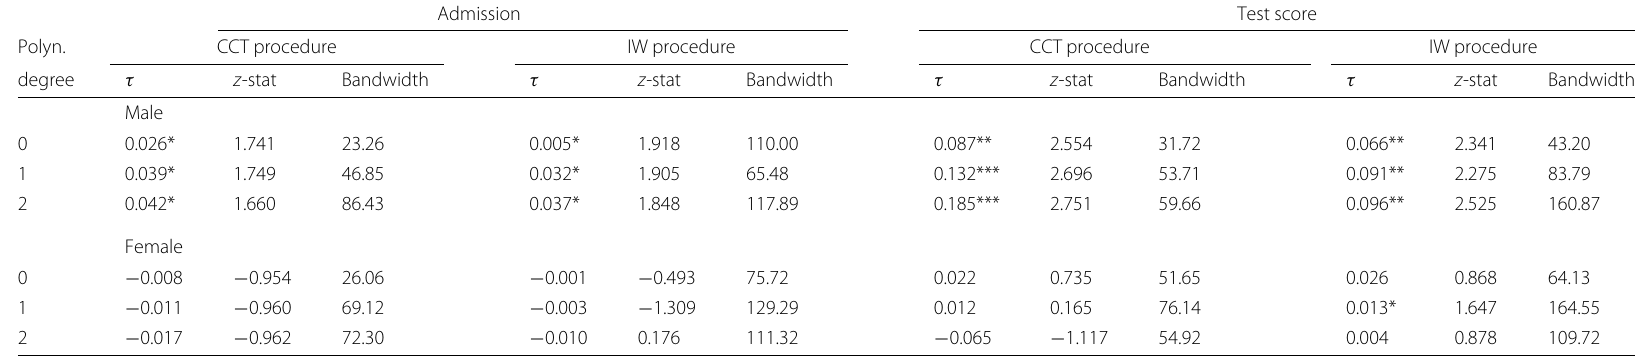
Table 4 RD estimates of college admission and test